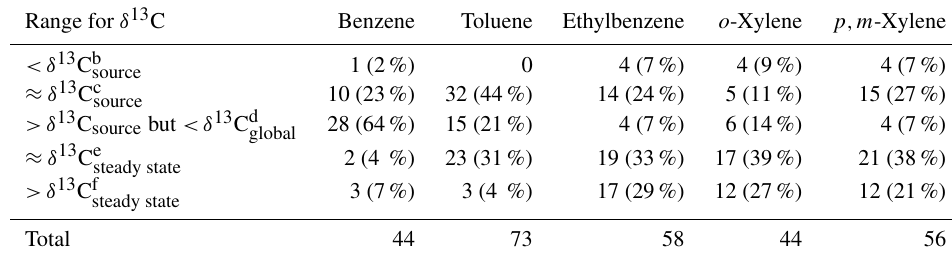
Table 11. Overview of the number of observations within different ranges of carbon isotope ratios a . Range for δ 13 C Benzene Toluene